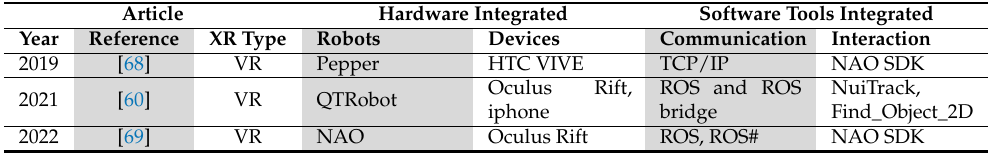
Table 5. Articles presenting XR solutions for social